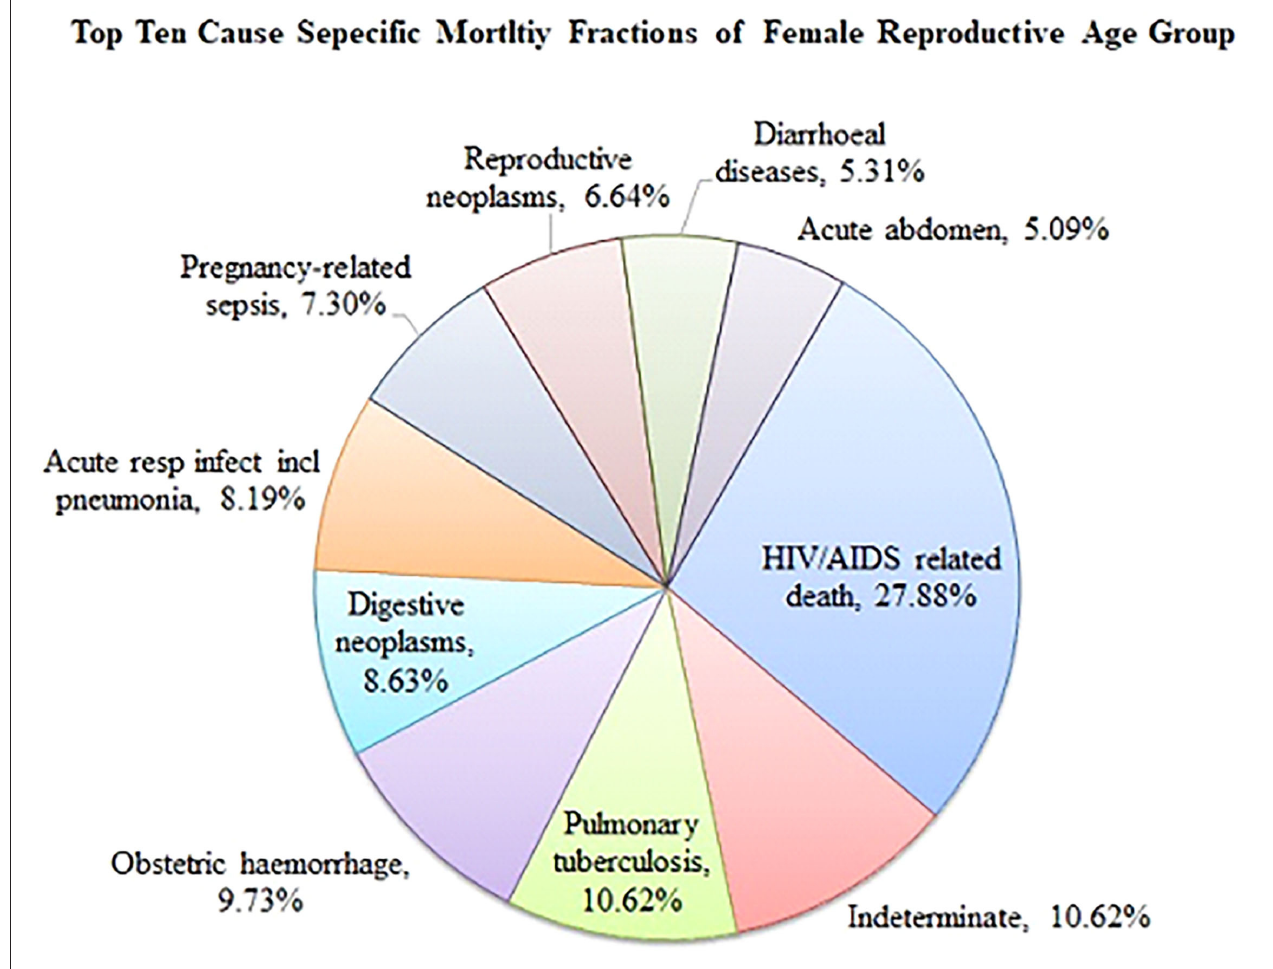
FIGURE 1 | Top 10 cause specific mortality fraction among reproductive age women in Kersa HDSS, eastern Ethiopia from 2008 to